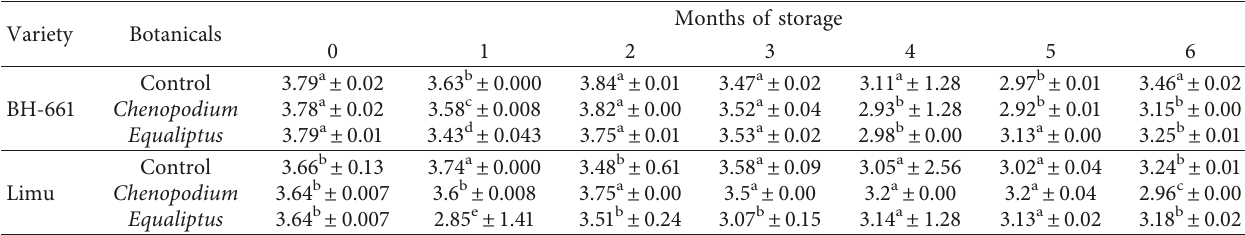
Table 5: Effect of botanicals and variety on square root of moisture content (mean ± SD) of